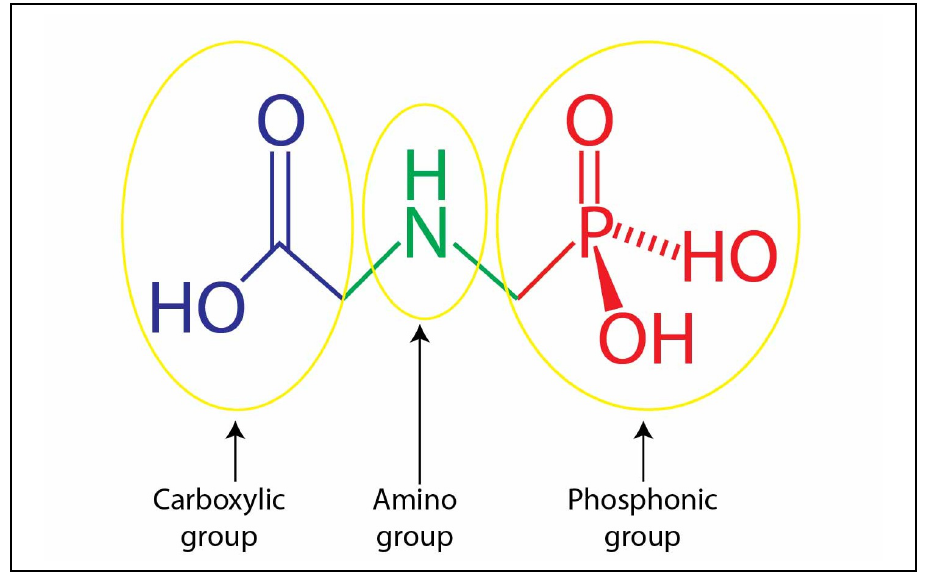
Figure 2. Structure of glyphosate molecule and its functional